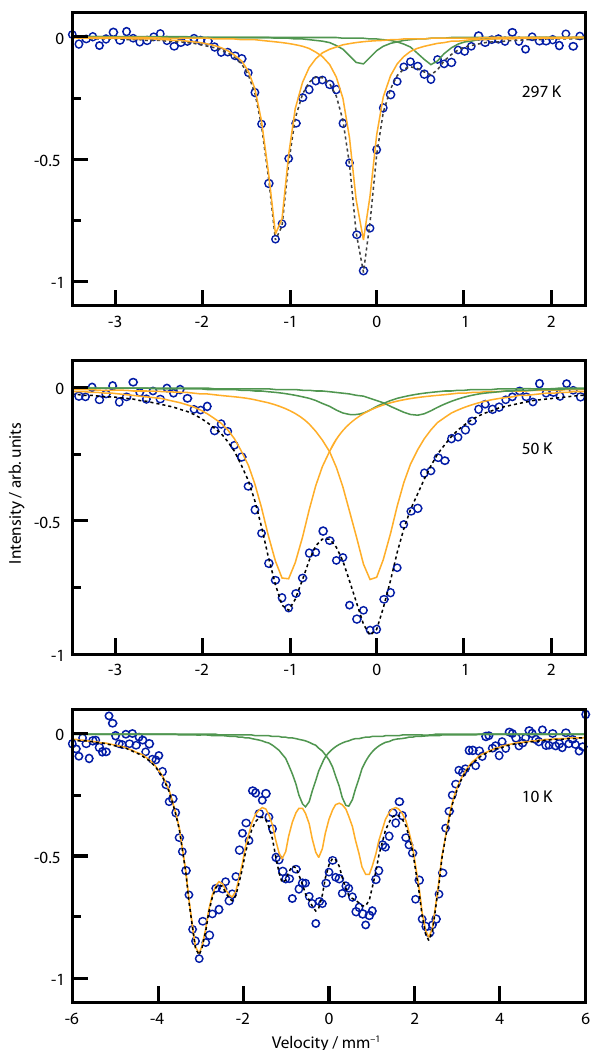
Fig. 3 57 Fe Mössbauer spectra of Ca 4 FeN 4 . Data (blue circles) were collected at 297, 50 and 10 K, orange curve belongs to Fe IV of Ca 4 FeN 4 , green curve belongs to an unidenti fi ed byproduct, grey dashed line is the sum of the individual curves. Green byproduct doublet appears at isomer shifts δ 297K = 0.22, δ 50K = 0.08, δ 10K = − 0.6 mm/s (intensity ratio Fe 4 + /Fe impurity = 85.8/14.2 was fi xed in the low temperature fi ts using the 297 K value).